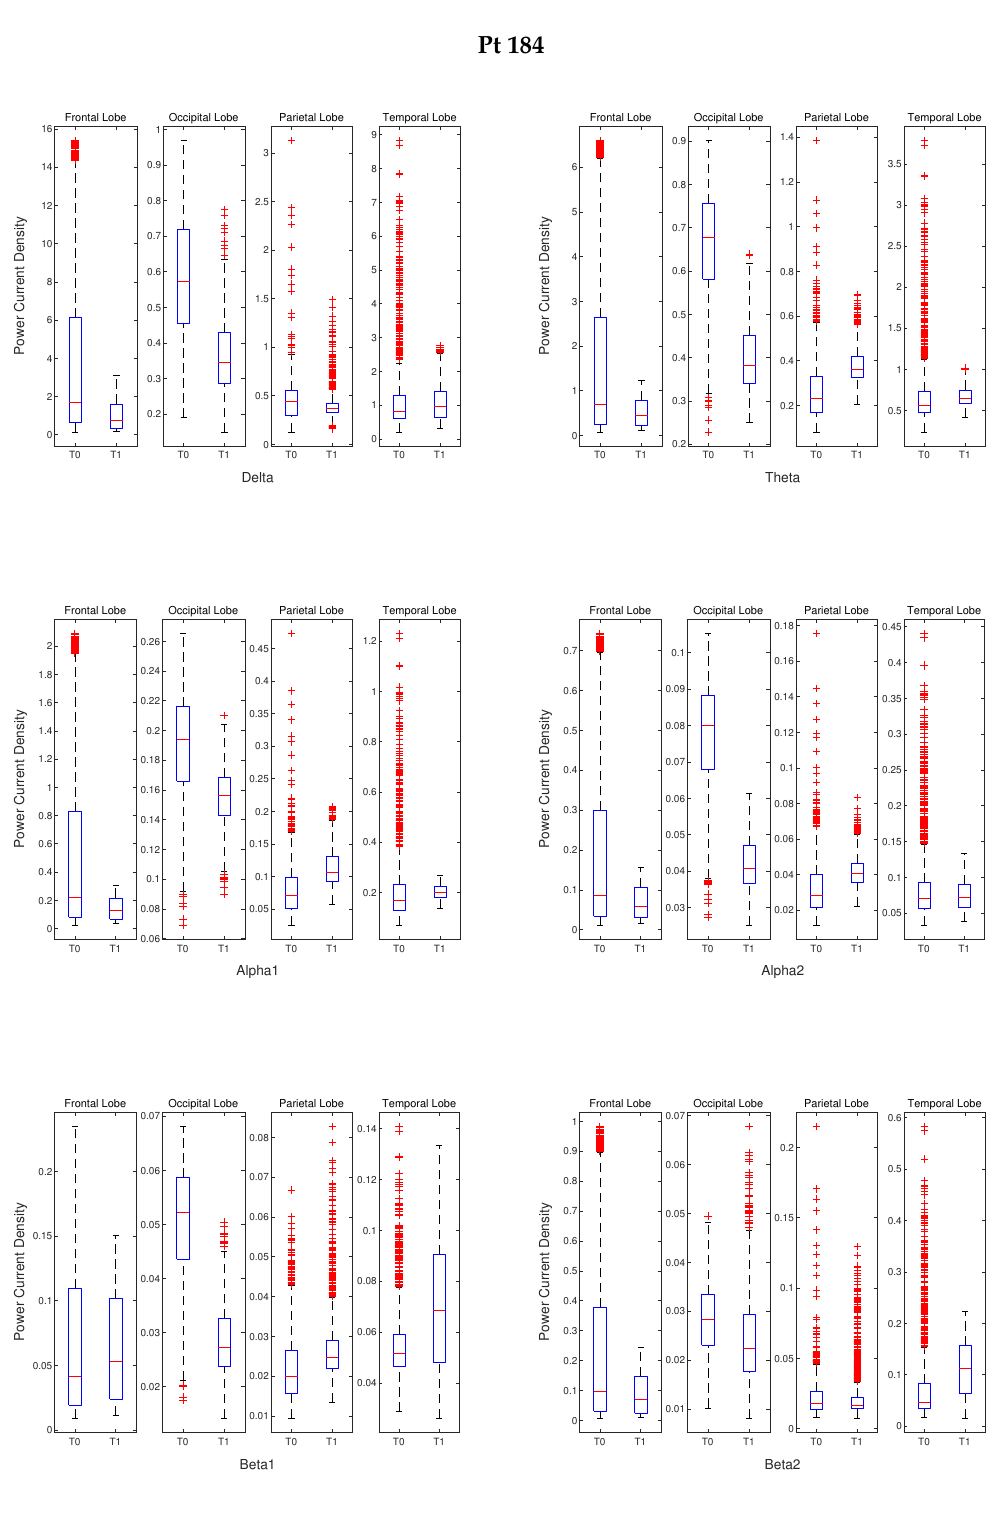
Figure 9. Boxplot of the power current density of patient 184 at time T0 and T1 for each frequency sub-band and each region of interest (frontal, occipital, parietal, and